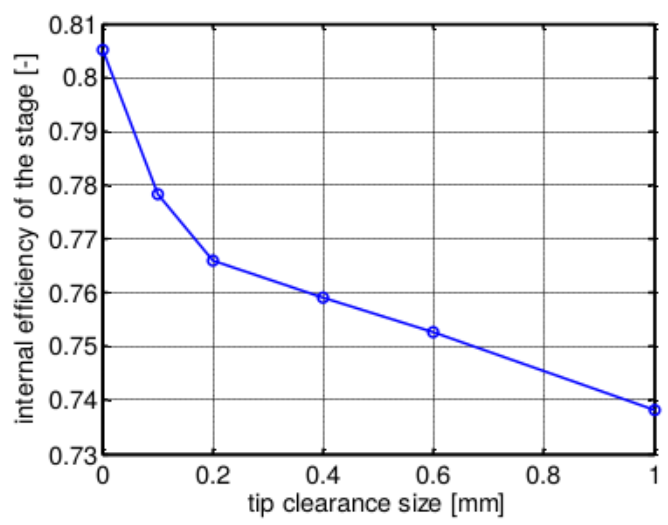
Figure 10: Internal efficiency of an examplary centripetal stage with respect to the tip clearance size.